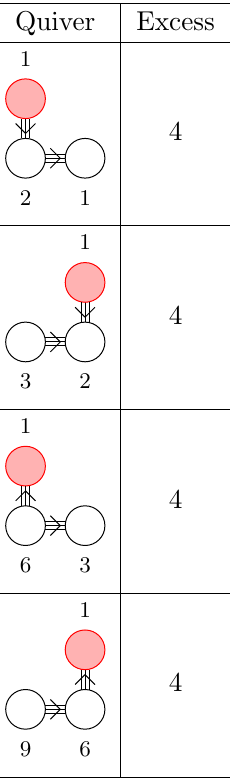
Hilbert Series which succinctly enumerates holomorphic functions in the ring. A one-to-one correspondence has been observed between holomorphic functions in the moduli space